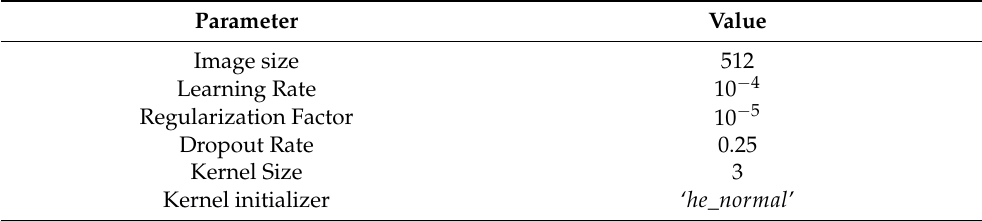
Table 1. U-Net configuration